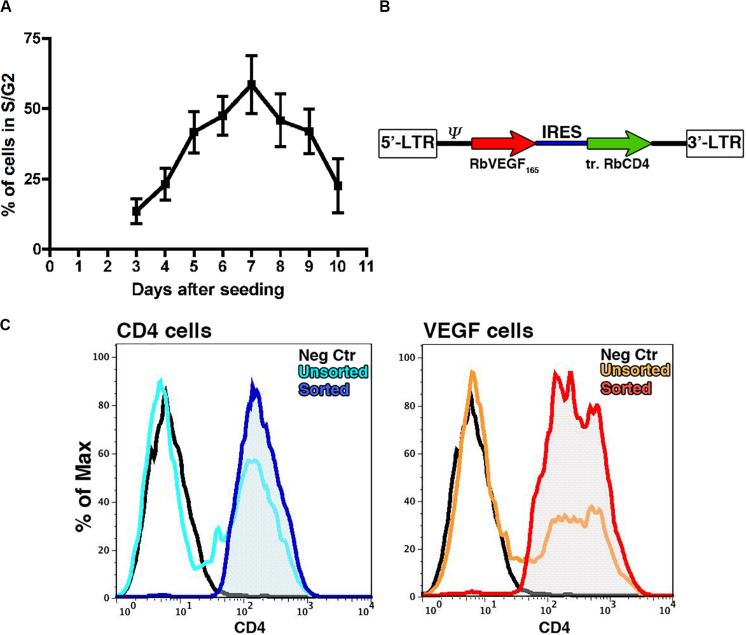
(A) Assessment by flow cytometry of the proportion of cells in active proliferation (S/G2 phases) at different time points after initial plating (n = 3). (B) Map of the bicistronic retroviral vector carrying the coding sequences of rabbit VEGF165 (rVEGF165) and of a truncated version of rabbit CD4 (tr.rCD4) linked through an Internal Ribosomal Entry Sequence (IRES). (C) Representative FACS plots for transduced rBMSC (light blue and orange plots) and FACS purified populations (blue and red plots) stained for CD4 as a marker of transduction; Isotype controls = black plots.